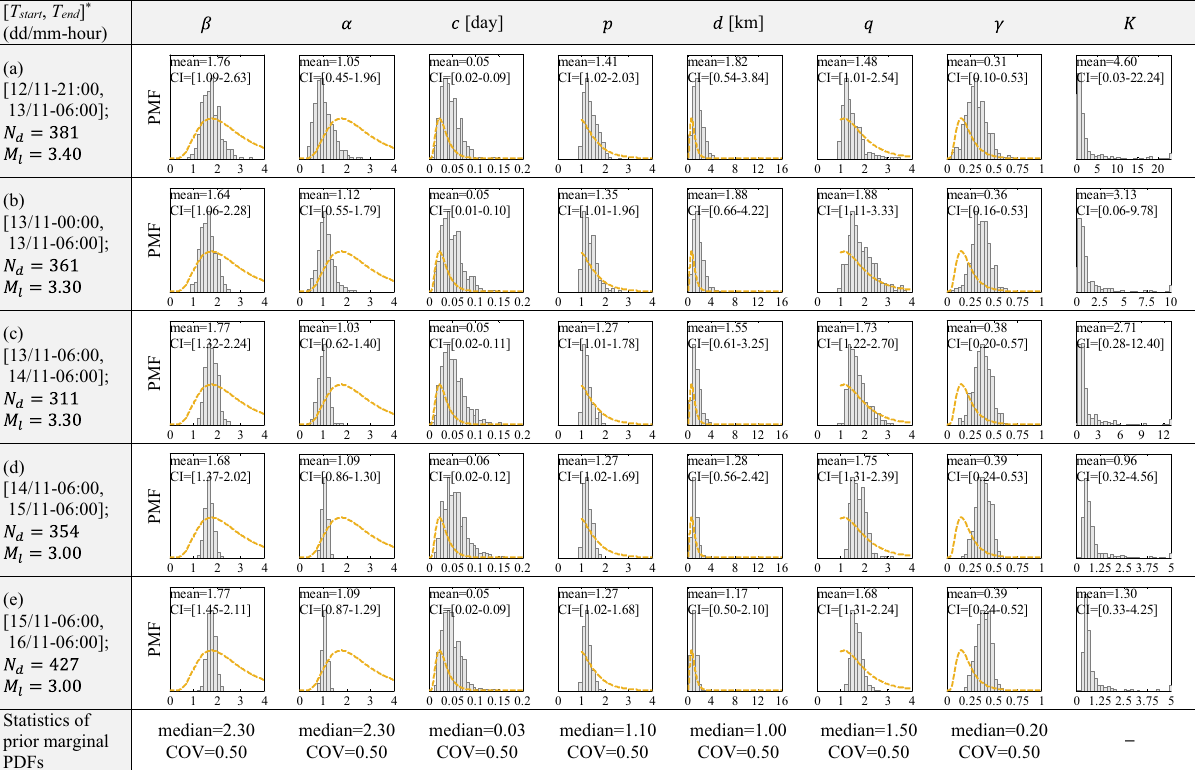
Table 1. Distribution of the ETAS model parameters including marginal PDFs of posterior (shown as histograms) and lognormal PDFs of prior (shown with dashed orange lines), and the statistics of posterior (including mean and [2%-98%] confidence interval (CI) for providing early seismicity forecasts after M w 7.3 at 12-November